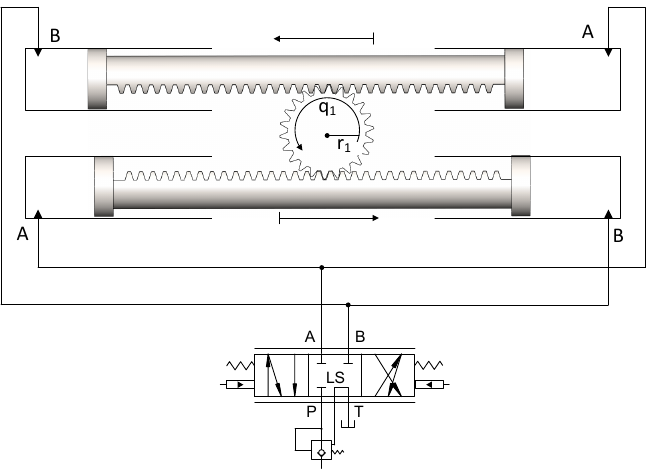
Figure 7. Rack-and-pinion mechanism at the test-bed manipulator’s base controlled using pressure- compensated proportional